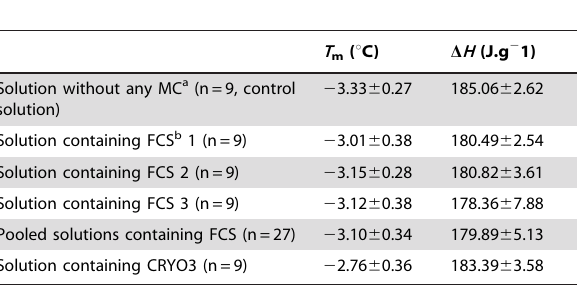
Table 1. Thermodynamic characteristics of the cryopreservation solutions (Mean 6 standard deviation).